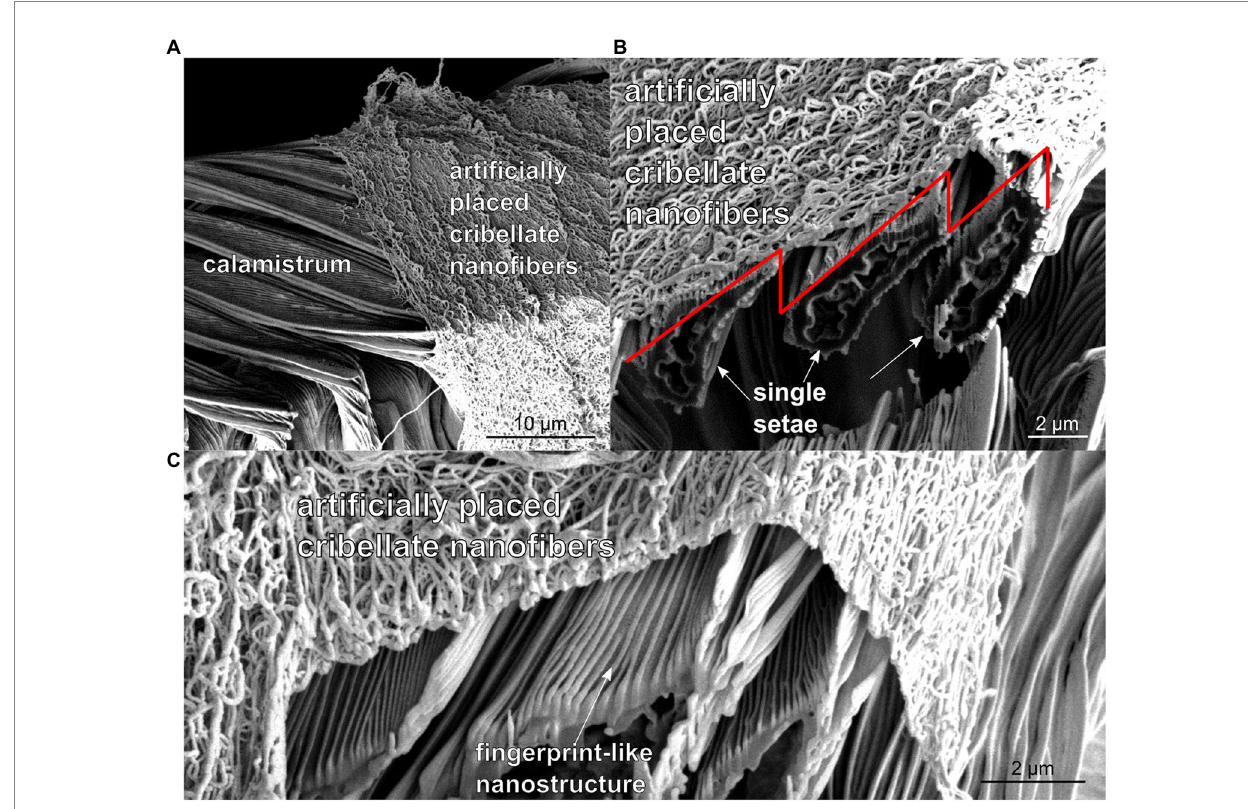
FIGURE 1 (A) SEM-image of the calamistrum of the feather-legged lace weaver Uloborus plumipes , with artificially placed cribellate nanofibers on top of it before cutting with focused ion beam (FIB). (B) SEM-image of the calamistrum after FIB cutting. The single setae can be abstracted as triangles (indicated by red line), which are overlapping each other in the final comb. (C) Further magnified SEM-image of the calamistrum after FIB cutting, in which the fingerprint-like nanostructure on the individual setae can be seen. The nanofibers are predominantly resting on the tips of these